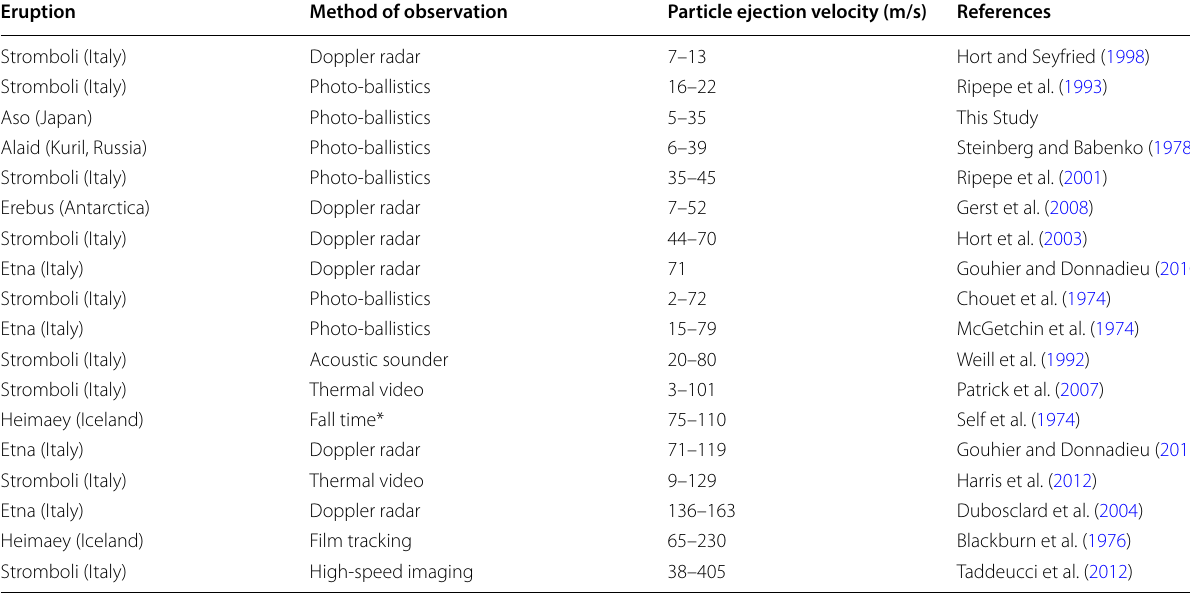
Table 4 Ballistic ejection velocities of Strombolian eruptions